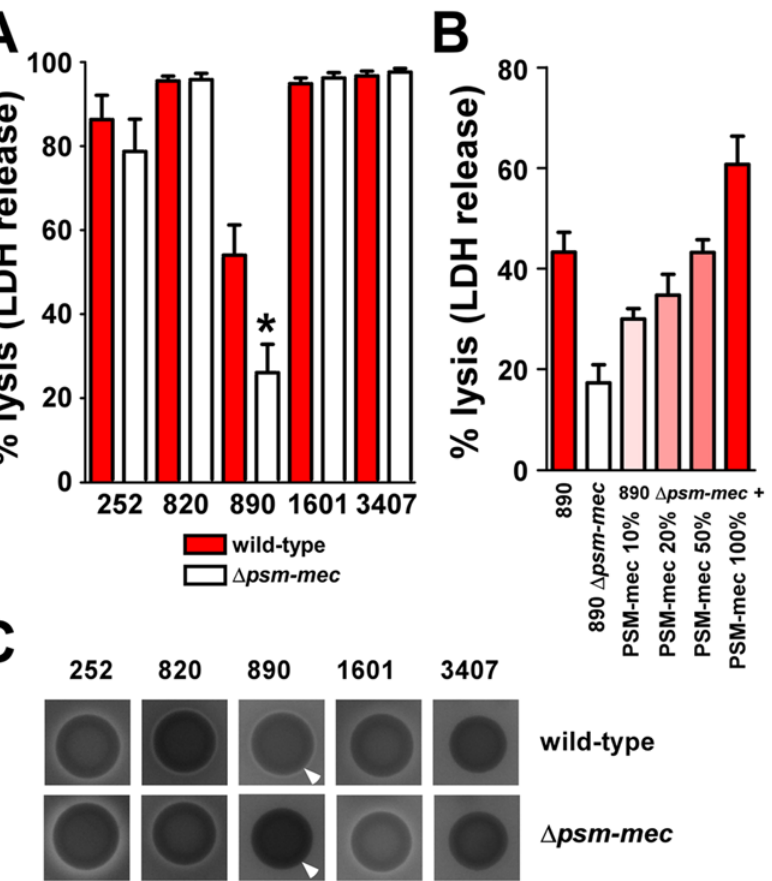
Figure 9. Cytolytic activities of S.aureu s PSM-mec producers and isogenic psm-mec deletion mutants. (A) Lysis of human neutrophils. Culture filtrates of strains were mixed with human neutrophils at a 1:10 dilution and lysis was measured after 1 h by release of lactate dehydrogenase (LDH). Values are means 6 SEM obtained from neutrophils of 5 independent donors. *, p=0.02 vs. wild-type. Differences between values for other wild-type and isogenic psm-mec deletion strains were not statistically significant. (B) Lysis of human neutrophils, complementation with PSM-mec. PSM-mec was added to culture filtrates of the psm-mec deletion strain in increasing concentrations (10, 20, 50, and 100% of the concentration detected in the wild-type strain). Experimentalconditionswerethesameas in(A).Values are means 6 SEMobtainedfromneutrophils of2to4independentdonors. (C)Synergistichemolysis. Strains were grown for 24 h on sheep blood agar plates. Arrows mark different zones of synergistic hemolysis in strains S. aureus MSA890 and its isogenic psm-mec deletionmutant. (A,B) 252, S.aureus Sanger 252;820, S. aureus MSA820;890, S. aureus MSA890;1601, S.aureus MSA1601;3407, S. aureus